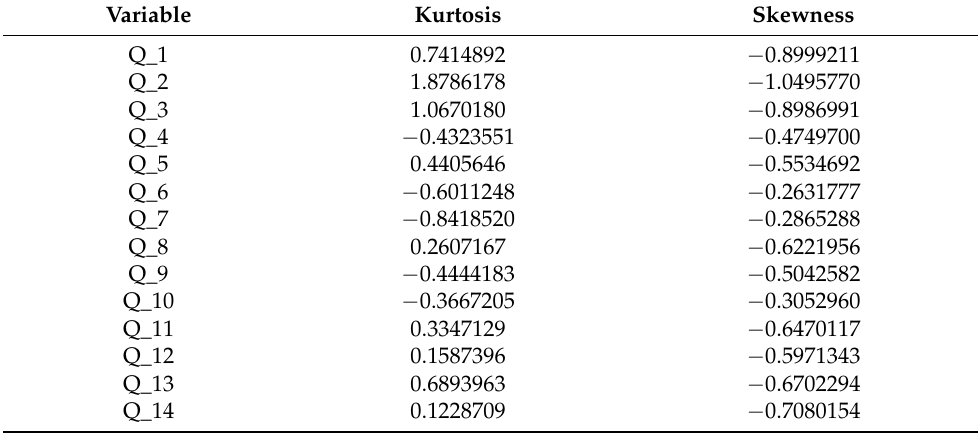
Table A1. Skewness and kurtosis values of LSQa